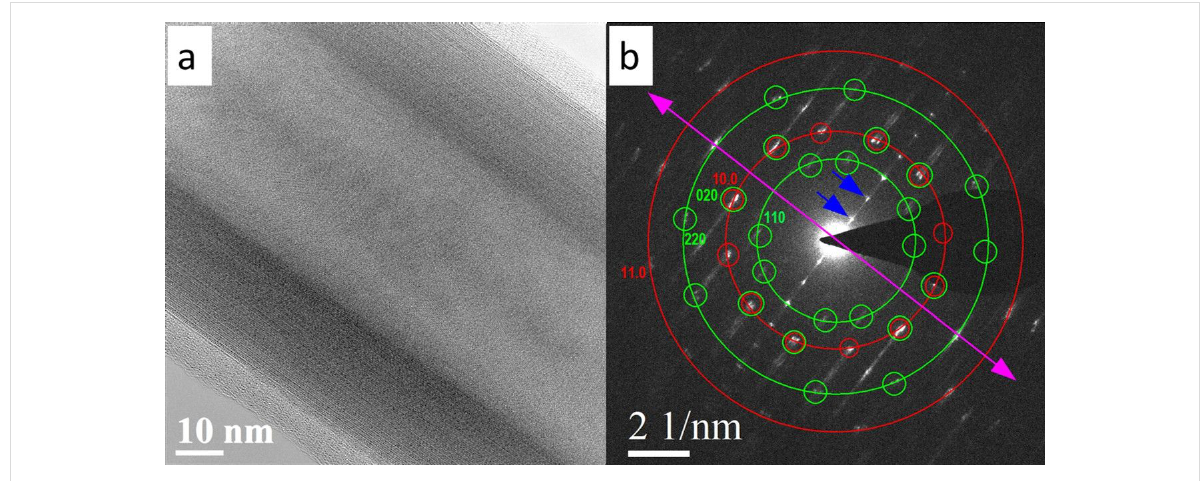
Figure 5: a) HRTEM image of a Sr x La 1 − x S–TaS 2 (10 atom % Sr in the precursor) nanotube showing 1.157 nm periodicity along the c -axis. b) Selected area electron diffraction showing the orientation relationship between LaS layers (green) and TaS 2 layers (red). The nanotube axis is shown as a pink arrow and the basal reflections are marked with blue arrows.